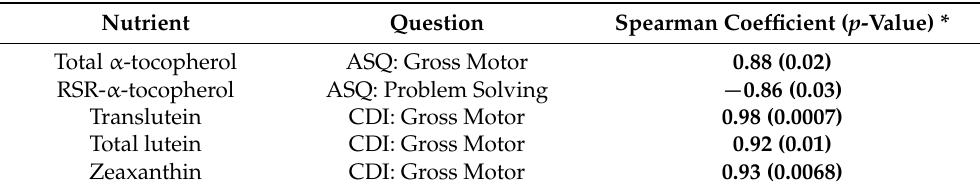
Table 4. Correlation between breastmilk nutrients and significant questionnaire categories for 14 participants with breastfeeding, outcomes, and breastmilk